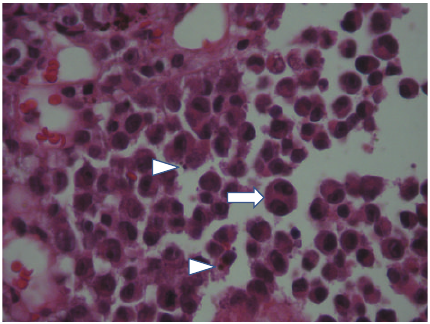
Figure 2: neoplastic cells demonstrated eosinophilic cytoplasm and eccentric nuclei with prominent nucleoli; some cells are binucleated ( ⇒ ); note the presence of pigment ( (cid:2) ) (HE × 400).